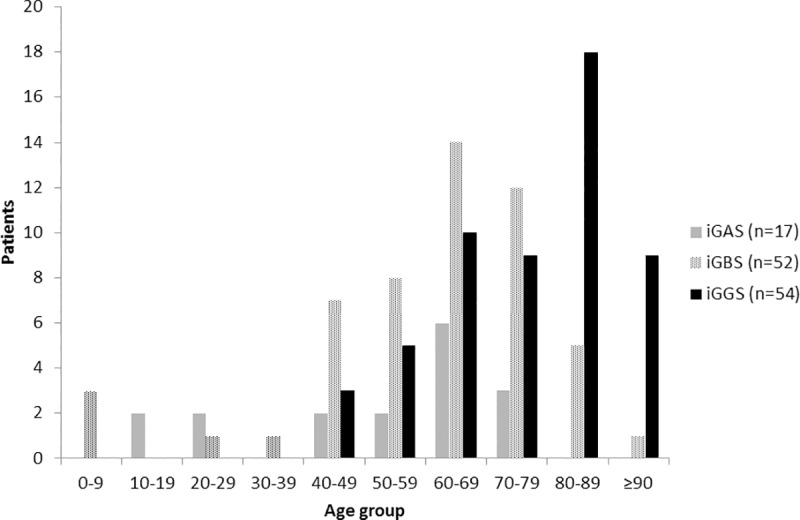
The number of patients with invasive streptococcal infections in each age group (2002–2013).